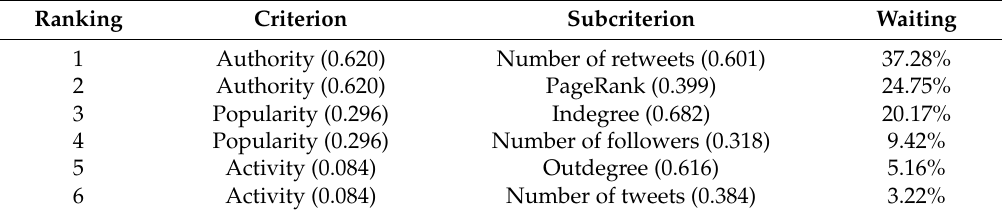
Table 4. Weighting of the subcriteria that determine the influence of a user on Twitter.